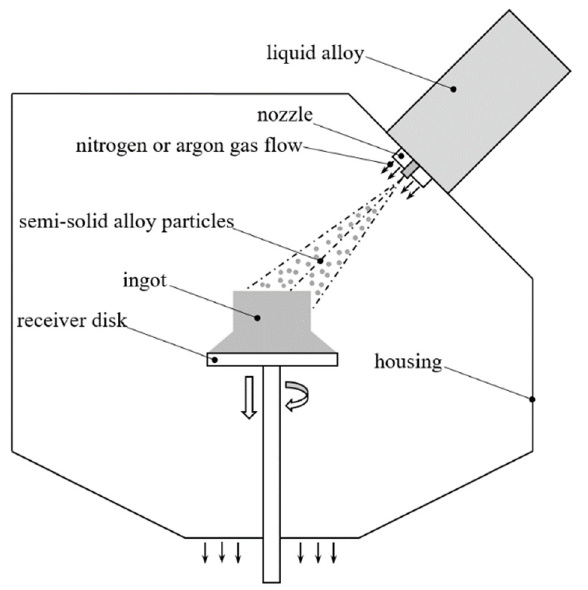
Figure 2. Schematic diagram of the spray-forming process. The AlSnCu alloy ingot prepared by semi-continuous casting is cylindrical, which needs to be rolled and heat treated to form the plate for making the bearing bush.